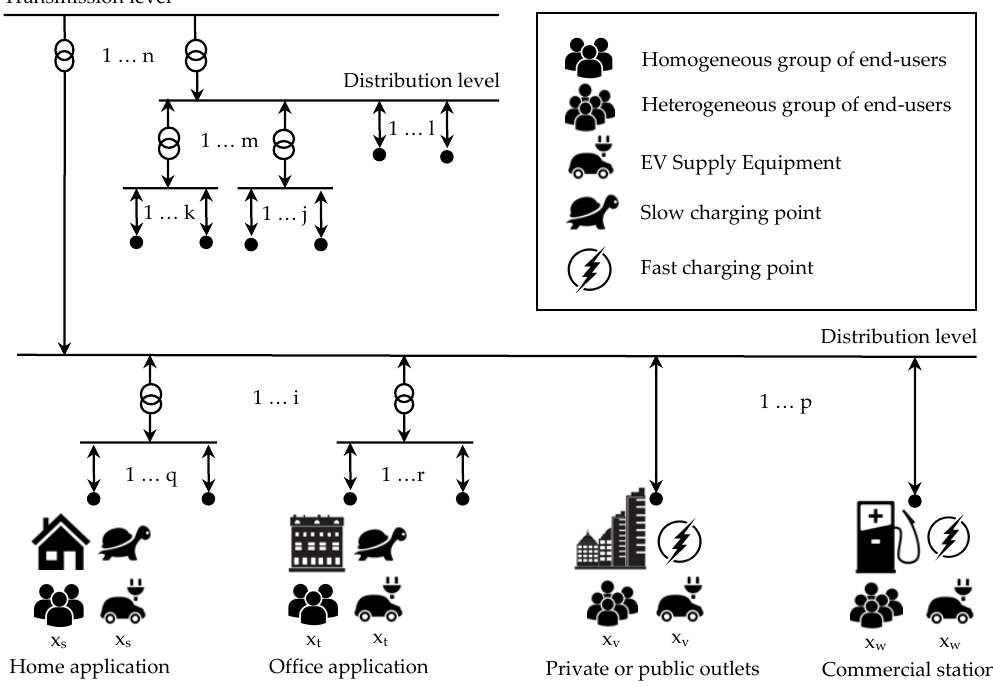
Figure 1. Schematic representation of the type of charging systems, and of their typical use and interaction within electric distribution networks. EV: Electric